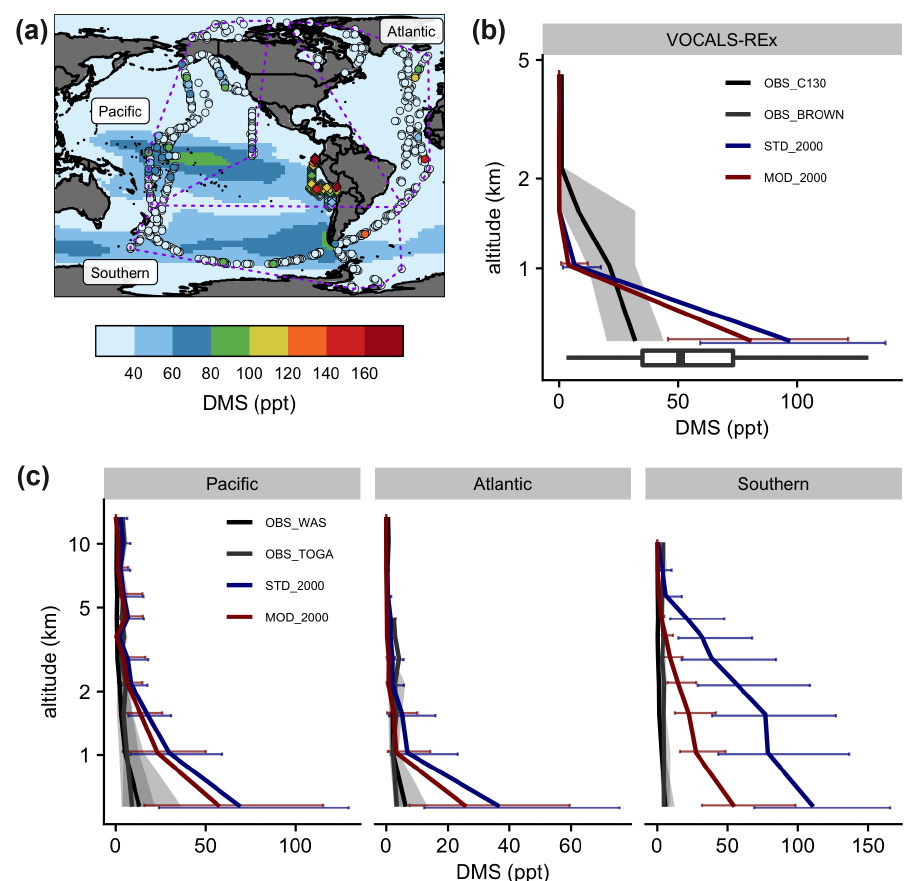
Figure 8. (a) Measurements of DMS during VOCALS-REx (diamonds in the southeastern Pacific near the coastline of Peru) and ATom (dots) missions. Measured values are showing local 90th percentiles above oceans. ATom data are grouped into three regions, as shown in the purple dashed polygons. Marine-only annual mean near-surface ( > 500hPa) DMS mixing ratios from [MOD_2000] are shown in the background as a reference. Vertically binned modeled and observed medians of DMS, during (b) VOCALS-REx and (c) ATom, are shown. Error bars and gray shadings indicate that the data ranged between corresponding upper and lower